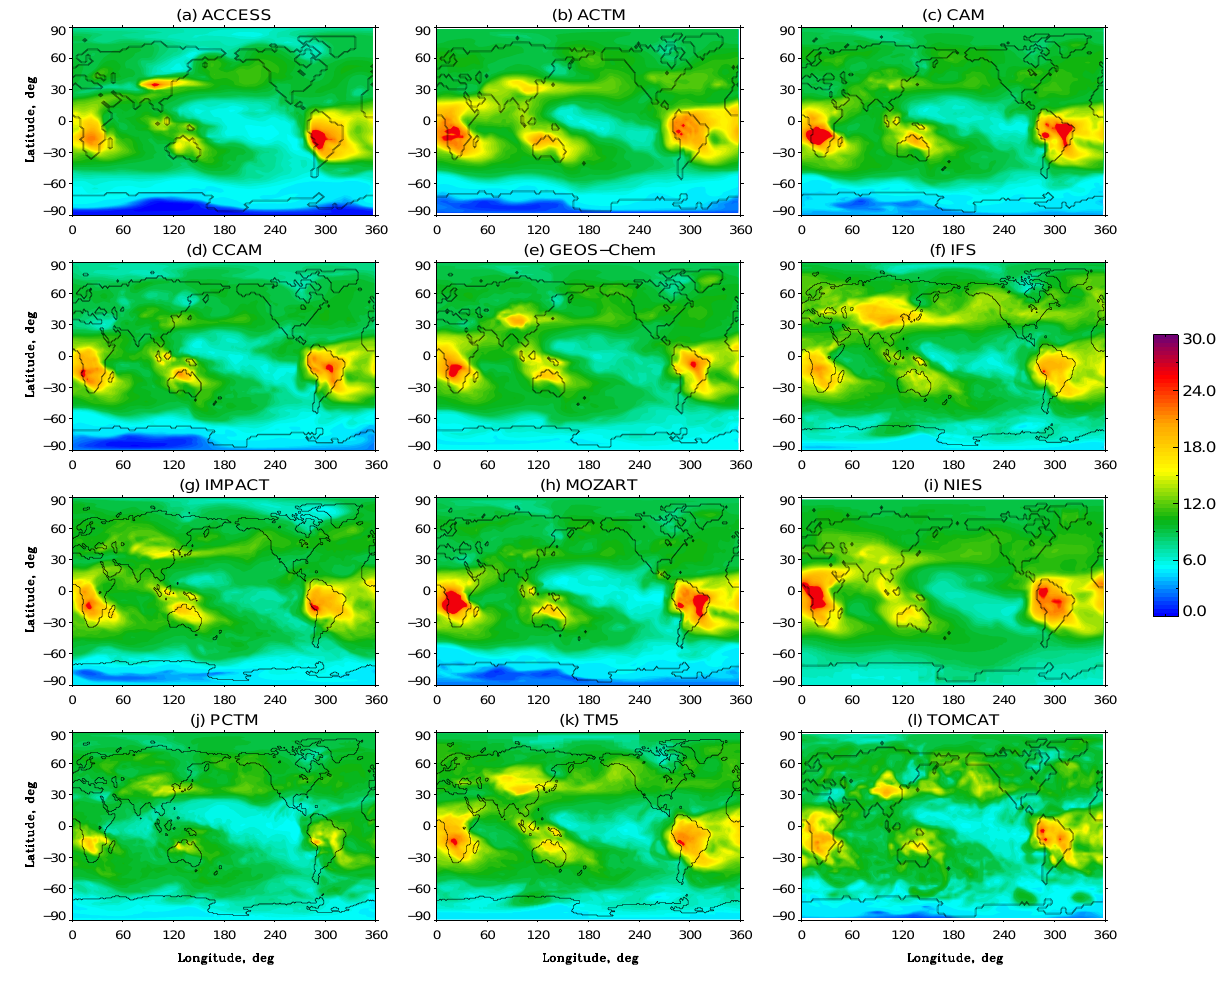
Fig. 5. As in Fig. 4, but at